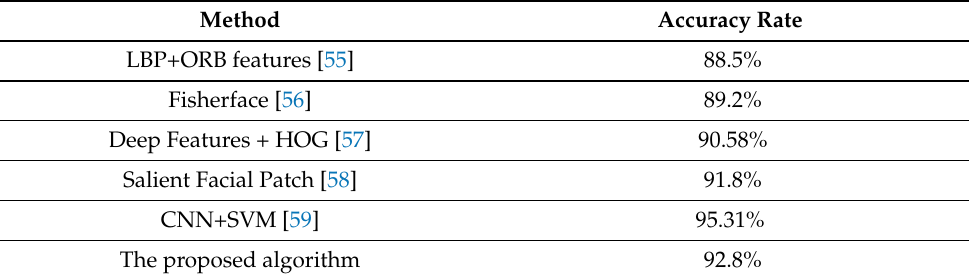
Table 3. Classification accuracy on the JAFFE dataset.